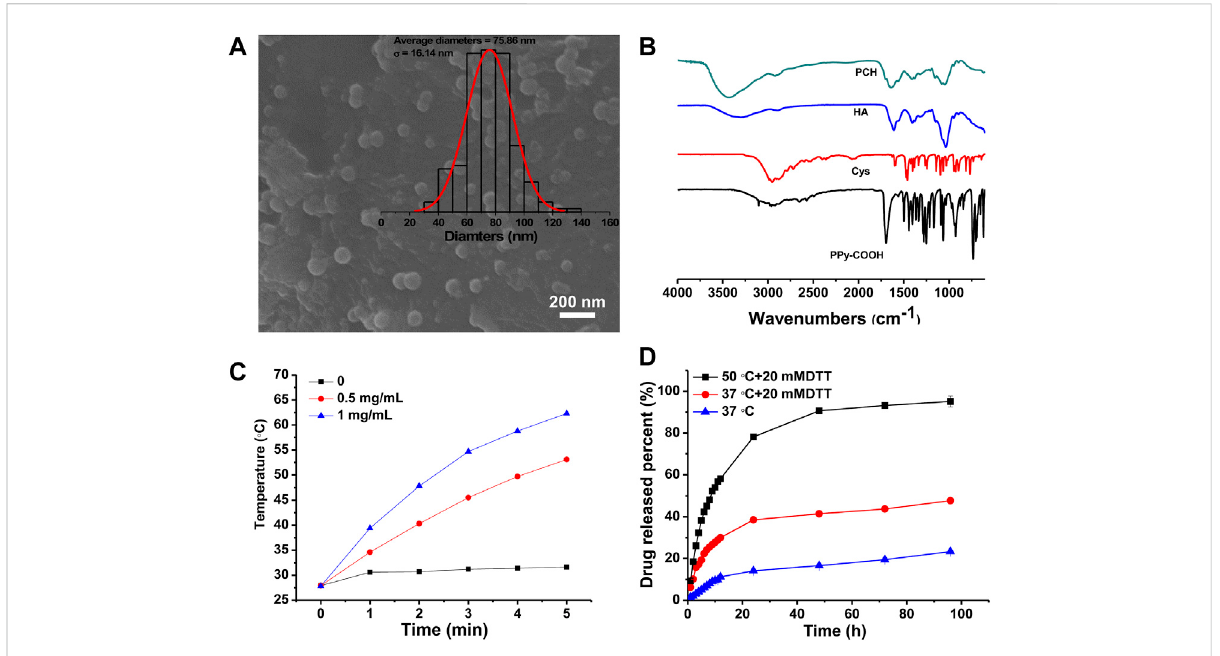
FIGURE 1 (A) SEM micrographs and diameter distribution histograms of PCH nanoparticles. (B) FTIR spectrum of PPy-COOH, Cys, HA, and PCH. (C) Temperature curves of PCH aqueous solutions (0, 0.5, 1 mg/ml) under laser irradiation of 1,064 nm laser at the power density of 1 W/cm 2 . (D) Cumulative release curve of PTX/PCH nanoparticles in different media and